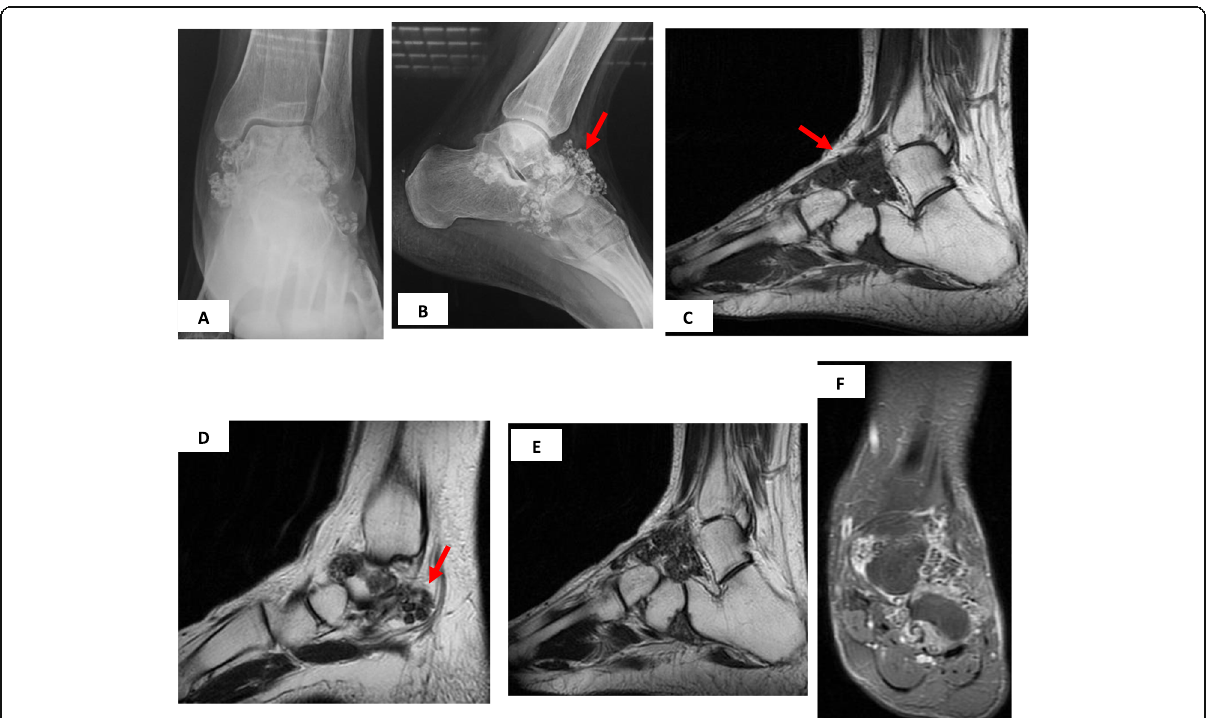
Fig. 2 Synovial chondromatosis in 52-year-old male with left ankle swelling. X-ray AP and Lat views ( a , b ) show multiple rounded uniform size calcified nodules (red arrows) around the ankle. Sagittal T1 ( c ), sagittal T2 ( d , e ), and coronal STIR ( f ) show low signal at T1 of the calcified nodules, low signal intensity of the periphery of the nodules with high signal of center due to bone marrow fat on T2 and